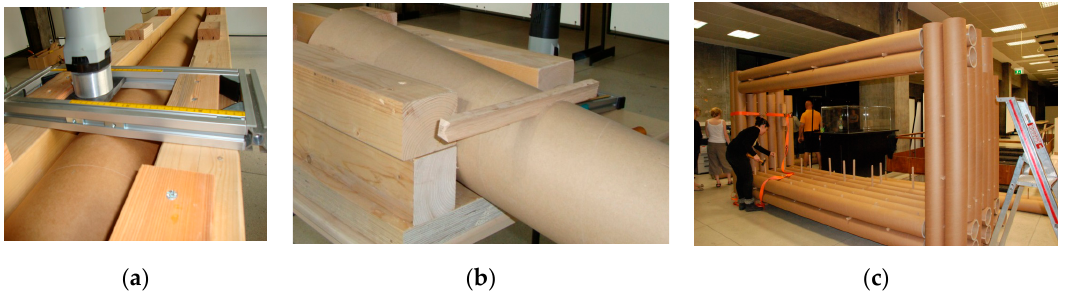
Figure 8. ( a ) Fixation of cartoon tubes and drilling holes for further assembling; ( b ) Pre-drilled holes in desired location for assembling with dry-connection bolts; ( c ) Interlocking dry-connection wooden bolts ensuring assembling and dismantling of the pavilions’ structure. (Photos: H. Dahy) © BioMat/ITKE-University of